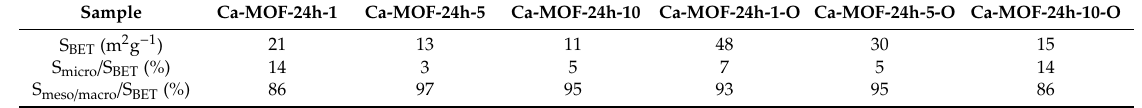
Figure 7. N 2 adsorption–desorption isotherms of ( a ) Ca-MOF-24h-y and ( b ) Ca-MOF-24h-y-O; mesopore size distribution curve of ( c ) Ca-MOF-24h-y and ( d ) Ca-MOF-24h-y-O.